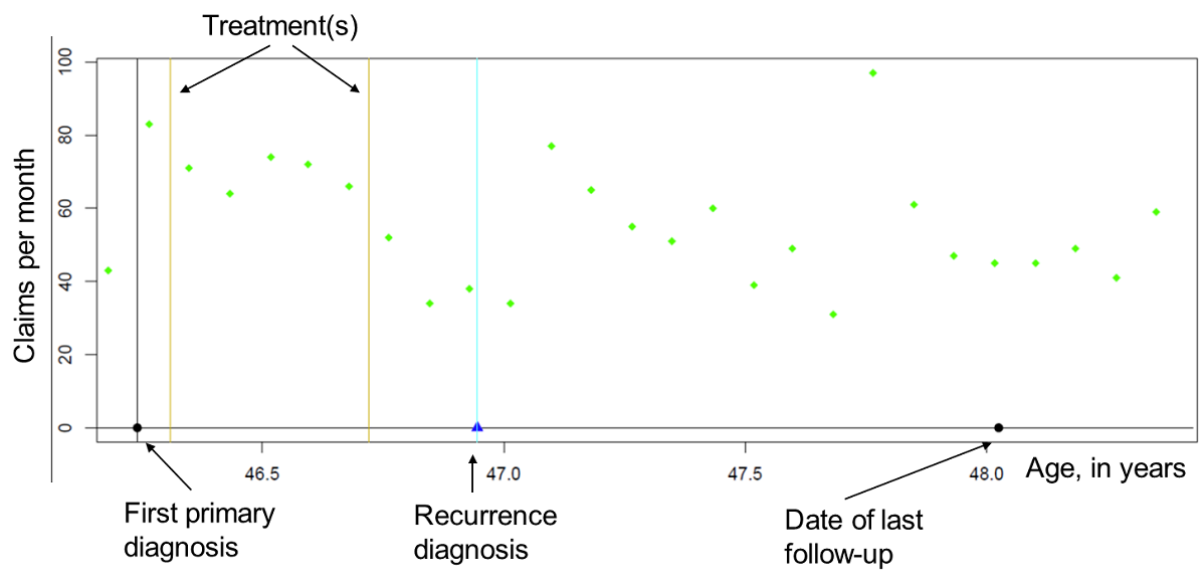
Figure 1. Sample plots for a hypothetical case showing a typical pattern of recorded claims each month before and after a second breast cancer event